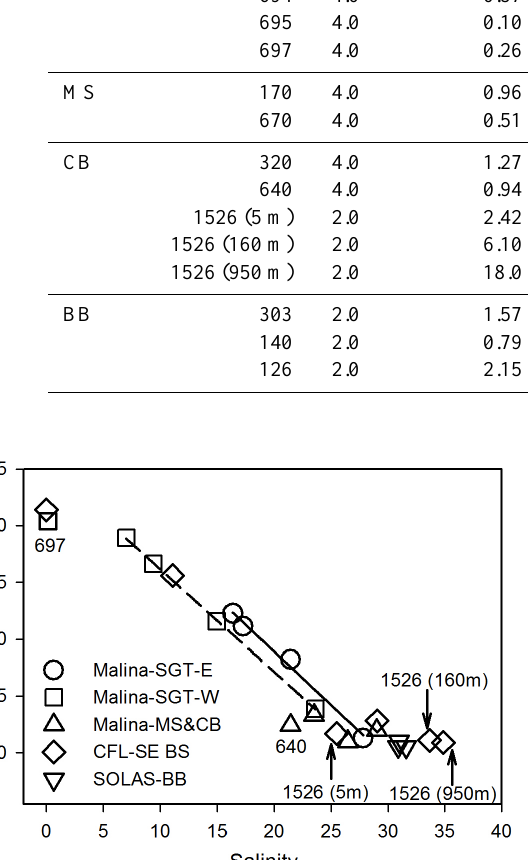
(Fig. 3b), where Q surf ,λ (mol photons m − 2 s − 1 nm − 1 ) de- notes the surface spectral solar photon flux at 70 ◦ N, 133 ◦